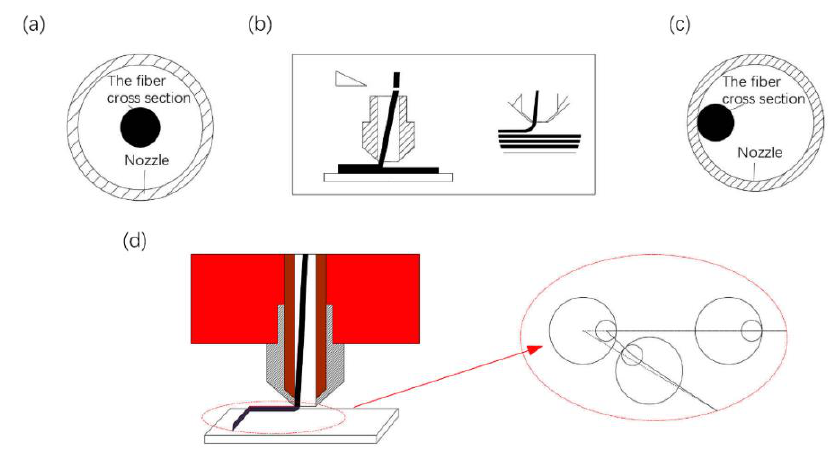
Figure 7. Fiber pose diagram in the nozzle, ( a ) initial position of fiber, ( b ) fiber upright state, ( c ) position during fiber movement, ( d ) print track graph.